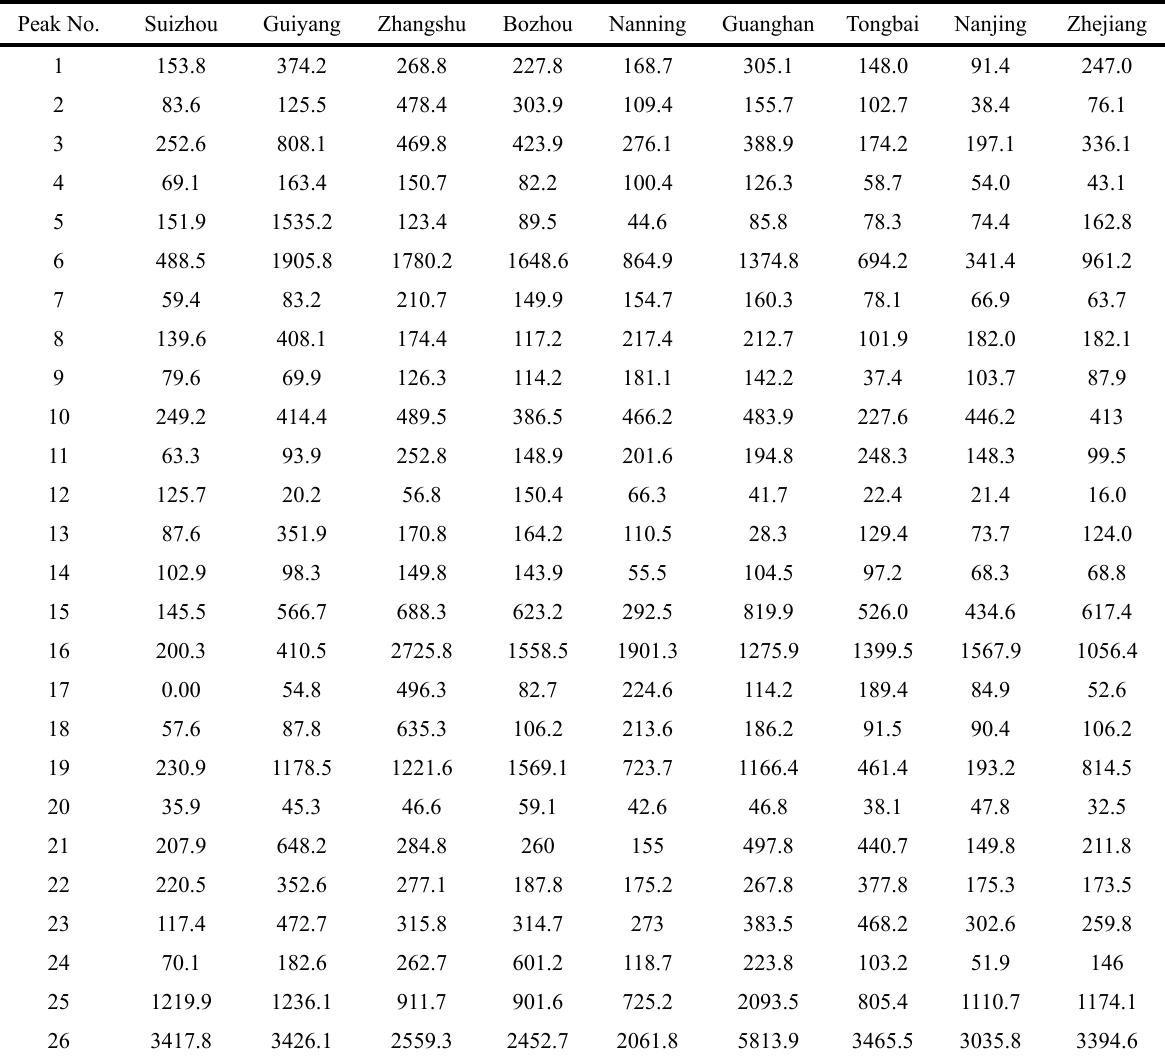
A,P-60 extract; B, P-95 extract. Table 1. Peak area comparison of the 26 compounds in Prunella from different regions. Peak